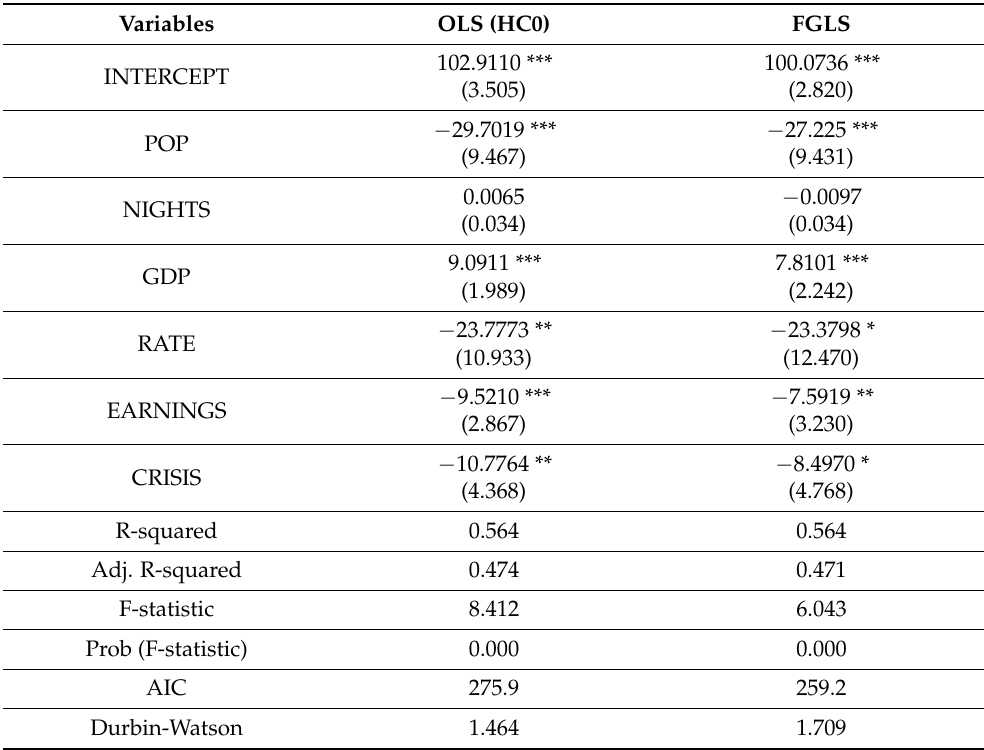
Table 2. Regressions output—determinants of real house price growth. Ordinary Least Squares Regression with robust standard errors (OLS (HC0)) and Feasible Generalized Least Squares with first order autoregressive covariance matrix. The standard error of each coefficient can be seen in parentheses below each